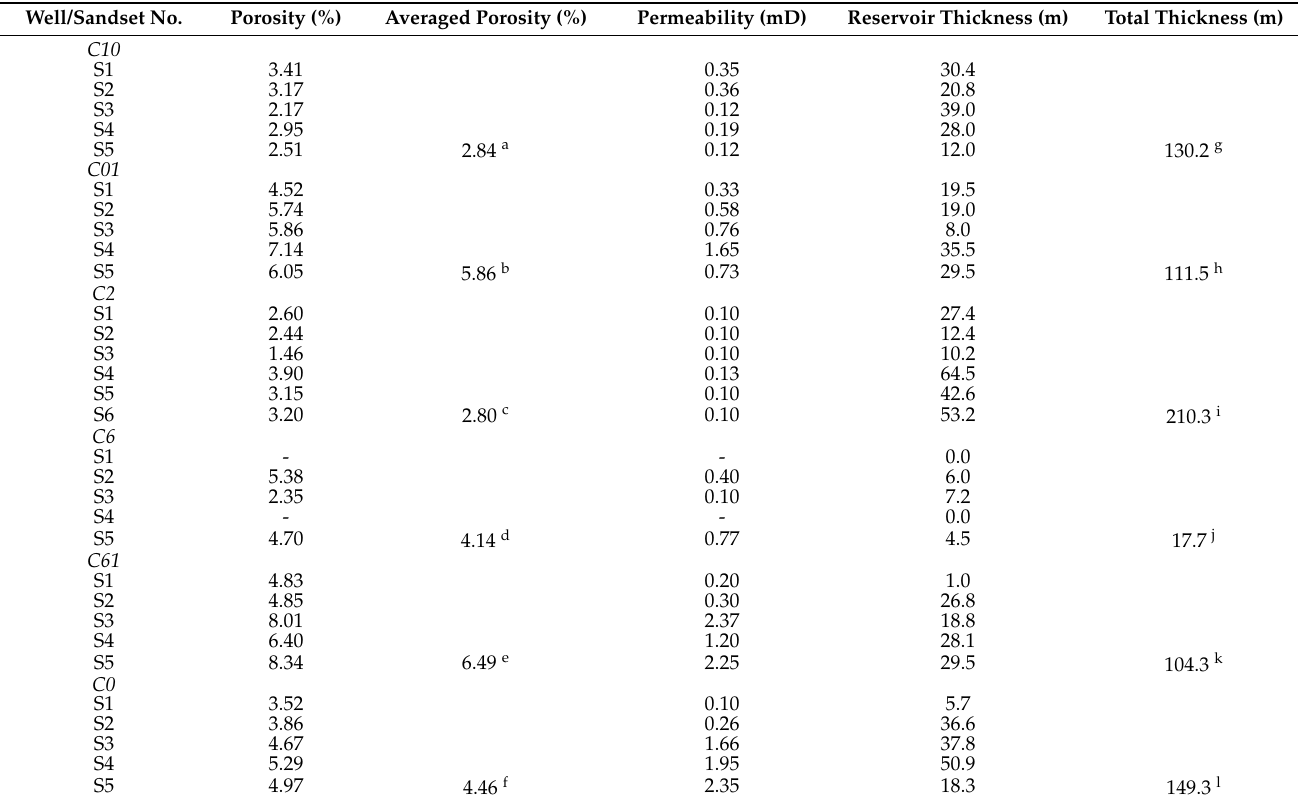
Table 3. The porosity, permeability, and reservoir thickness derived from seven wells from the Es 3L Formation in the Chezhen depression. Well/Sandset No.